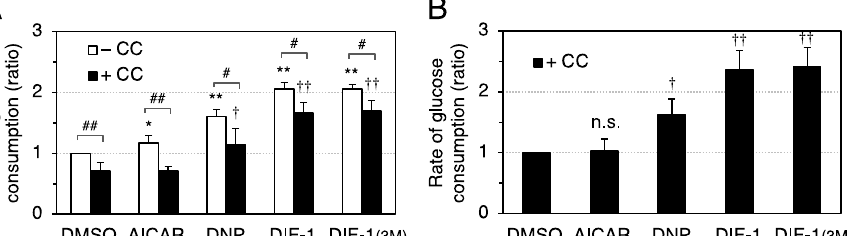
Figure 5. Effects of compound C on DIF-induced glucose consumption in confluent 3T3-L1 cells. Cells were pre-incubated for 0.5 h with 15 µ M compound C (CC) and further incubated for 8–15 h in the presence of DMSO (0.3%), AICAR (0.1 mM), DNP (50 µ M), DIF-1 (15 µ M), or DIF-1(3M) (15 µ M). The glucose concentration of each medium was measured, and the rates of glucose consumption are shown relative to the DMSO control (–CC) in ( A ) and to the DMSO control (+CC) in ( B ). The mean values and SD of the four independent experiments are presented. * p < 0.05, ** p < 0.01 versus DMSO control (–CC); † p < 0.05, †† p < 0.01 versus DMSO control (+CC); # p < 0.05, ## p < 0.01; n.s., not significant.